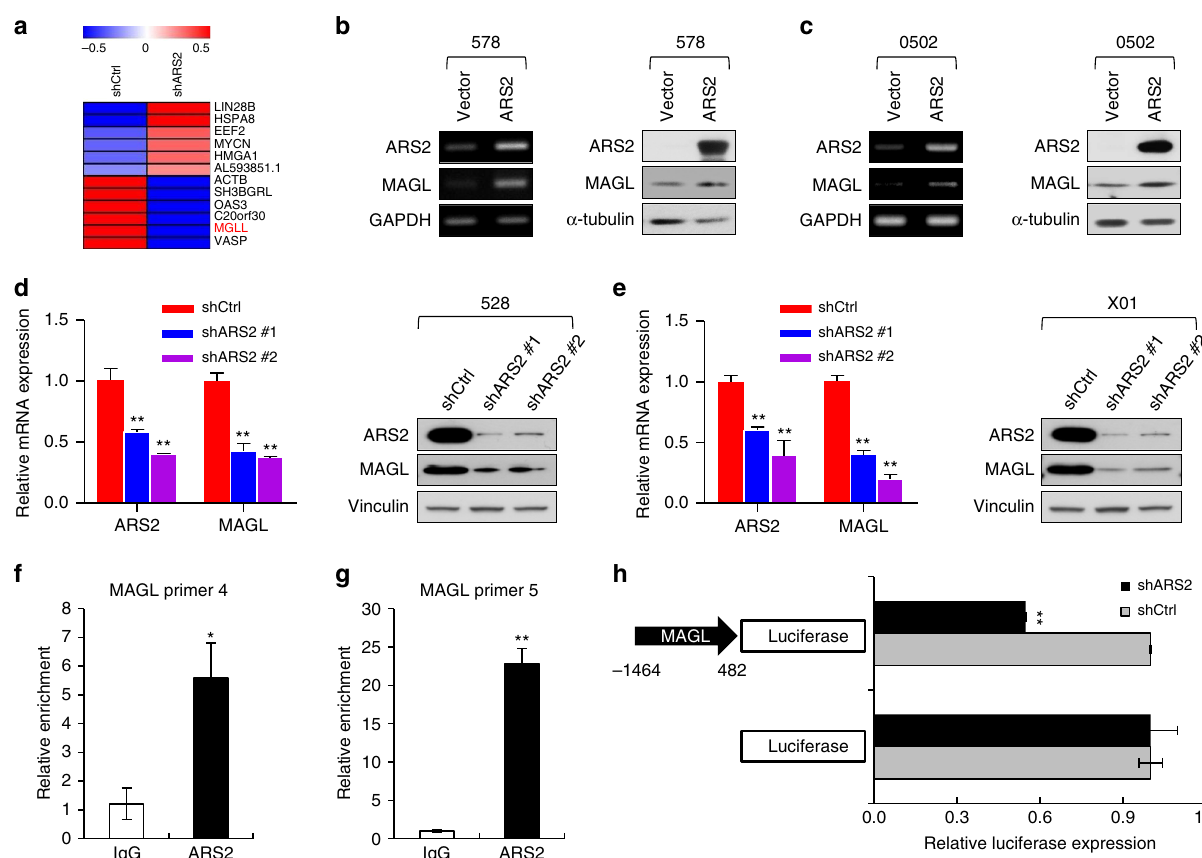
Fig. 3 ARS2 directly activates transcription of MGLL . a Heatmap analysis of gene expression in X01 cells infected with a shARS2-expressing lentiviral or shCtrl construct. b , c PCR (left) and immunoblot (IB) analysis (right) of ARS2 and MAGL in GSCs (578 and 0502 cells) infected with an ARS2-expressing lentiviral or vector construct. GAPDH or α -tubulin was used as a loading control. d , e qRT-PCR (left) and IB analysis (right) of ARS2 and MAGL in GSCs (528 and X01 cells) infected with a shARS2-expressing lentiviral or shCtrl construct. Vinculin was used as a loading control. All error bars represent mean ± SEM ( n = 3). * P < 0.05, ** P < 0.01, t -test. f , g Immunoprecipitated chromatin was analyzed by qPCR using 3- and 4-speci fi c primers on the promoter region of the MAGL gene. All error bars represent mean ± SEM ( n = 3). * P < 0.05, ** P < 0.01, t -test. h Luciferase reporter assays of MAGL activity in GSCs (X01 cells) infected with a shARS2 – expressing lentiviral or shCtrl construct. All error bars represent mean ± SEM ( n = 3). ** P < 0.01, t